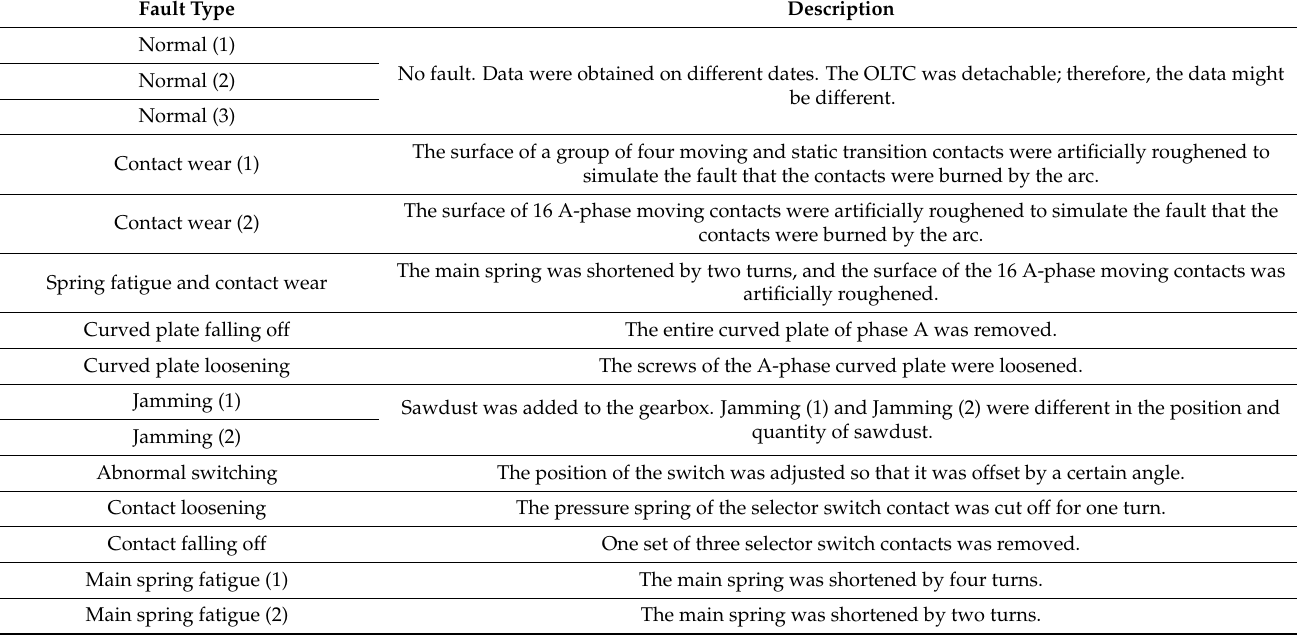
Table 2. Descriptions of fault